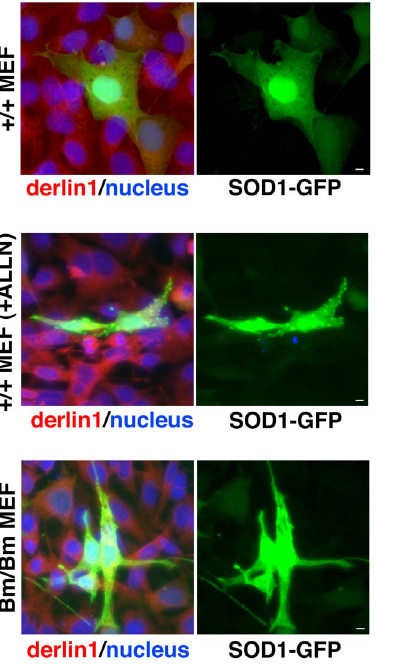
Figure 7. Aggregations were obvious in the mutant BiP MEF. The aggregations by transient expressions of SOD1-GFP were evaluated by immunofluorescence microscopy with labeling by using a rabbit anti-Derlin1 antibody for the ER staining (red) and SOD1-GFP (green) in wild type ( + / + ) and the homozygous mutant (Bm/Bm) MEF with Hoechst 33342 for nuclear staining. Scale bars, 10 um. Aggregations of SOD1were observed in the mutant BiP MEF as well as in the wild type MEF treated with a proteasome inhibitor, ALLN (10 ug/ml), at 37 u C